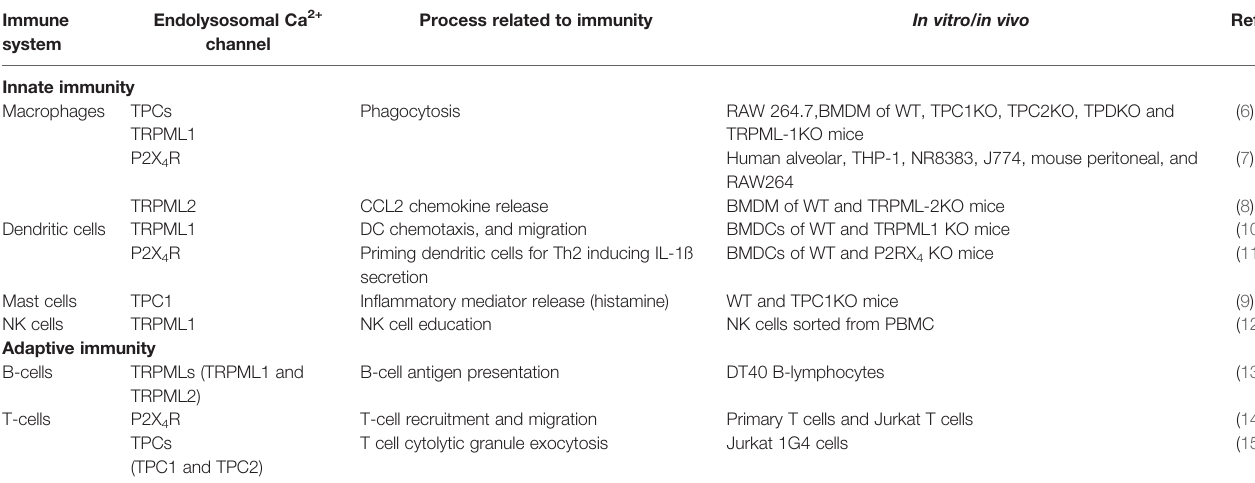
TABLE 1 | Some experimental evidence supporting endolysosomal Ca 2+ signalling involvement in physiological processes attributed to immunity. Immune